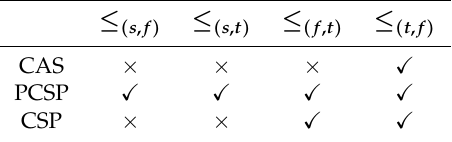
Table 1. Compatible properties of lexicographic